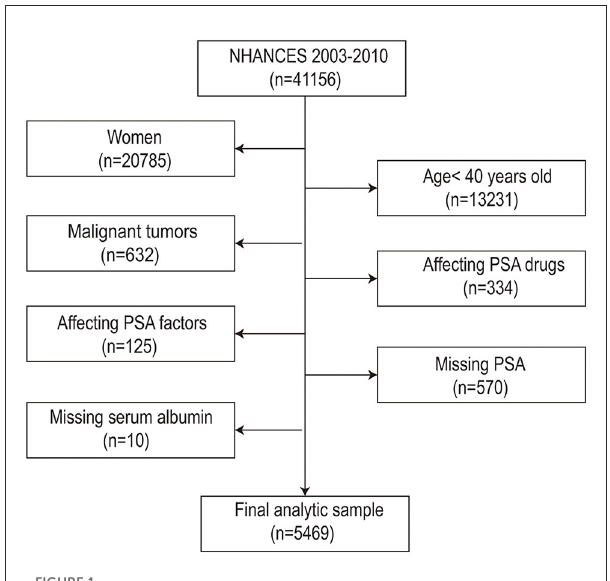
FIGURE1 Flow chart of procedures from identification of eligible patients to final